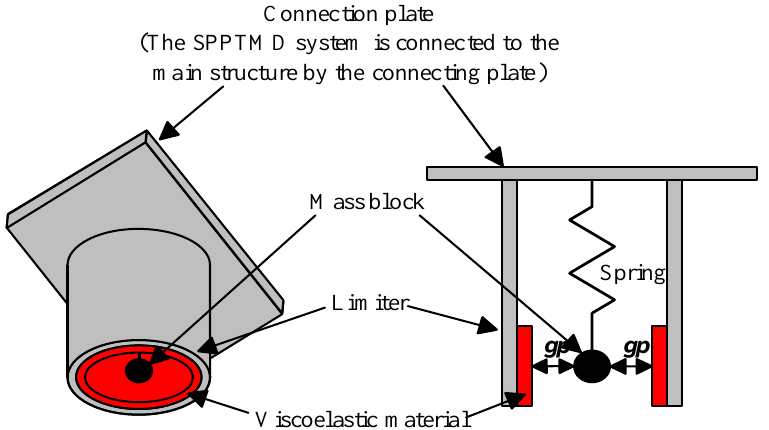
Figure 5. Spring pendulum pounding tuned mass damper (SPPTMD) system designed for controlling the vibration of a structure.